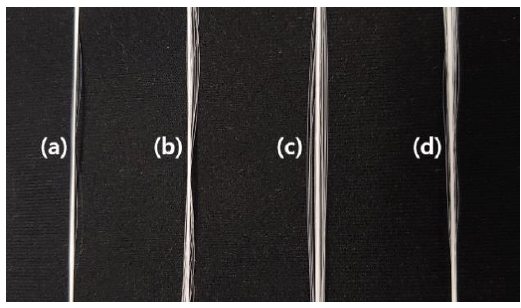
Figure 1. Wet spinning system used in this study.